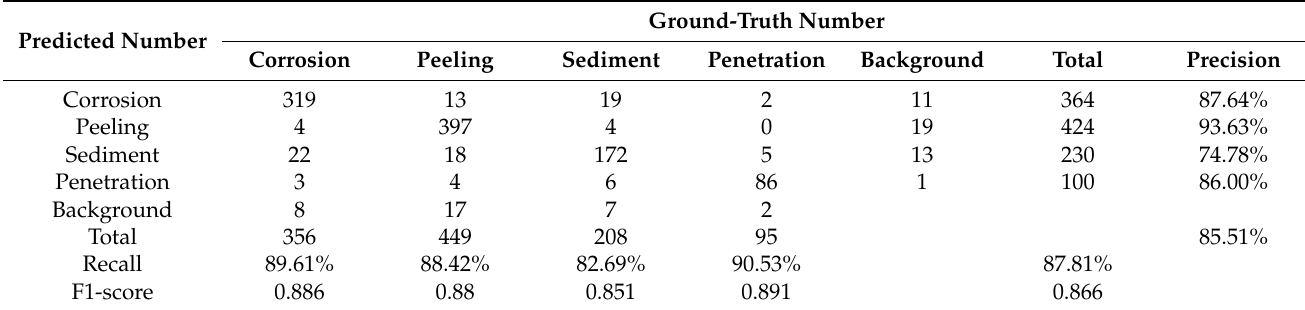
Table 5. Defect detection result based on unstitched images.